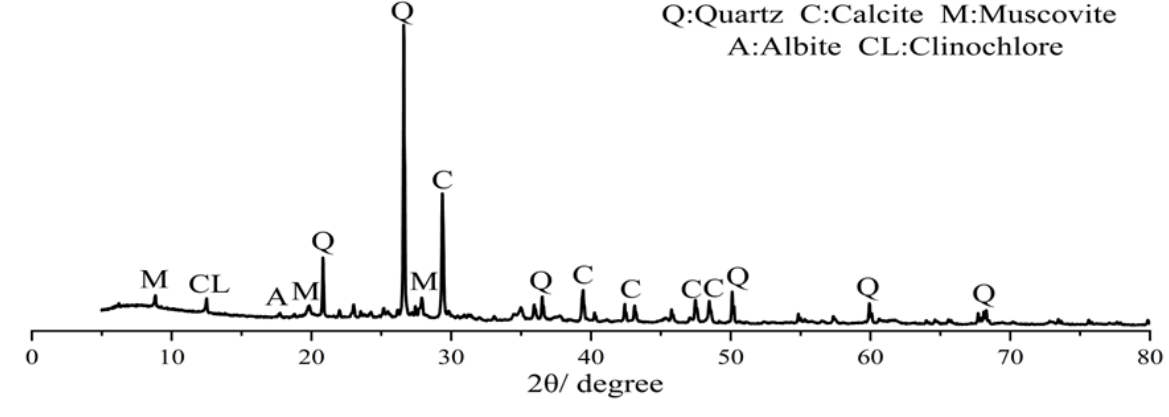
Figure 5. X-ray diffraction curves of soil.